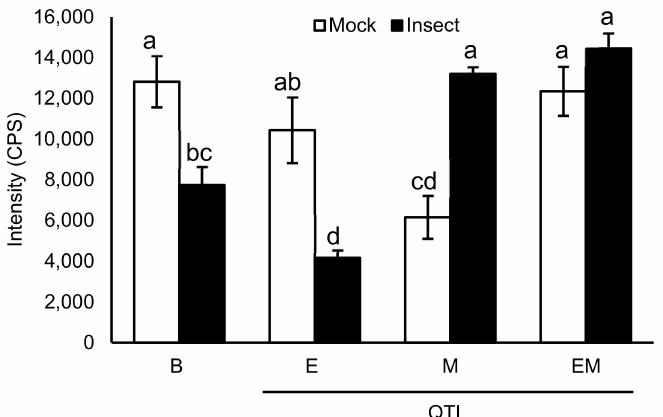
Figure 3. Average daidzein levels in mock and insect treated leaves of soybean QTLs and the insect- susceptible parent Benning. Different letters show significant differences by single factor ANOVA, Tukey post hoc test ( p < 0.05, α = 0.05). Error bars indicate SE ( n = 3 biological replicates).